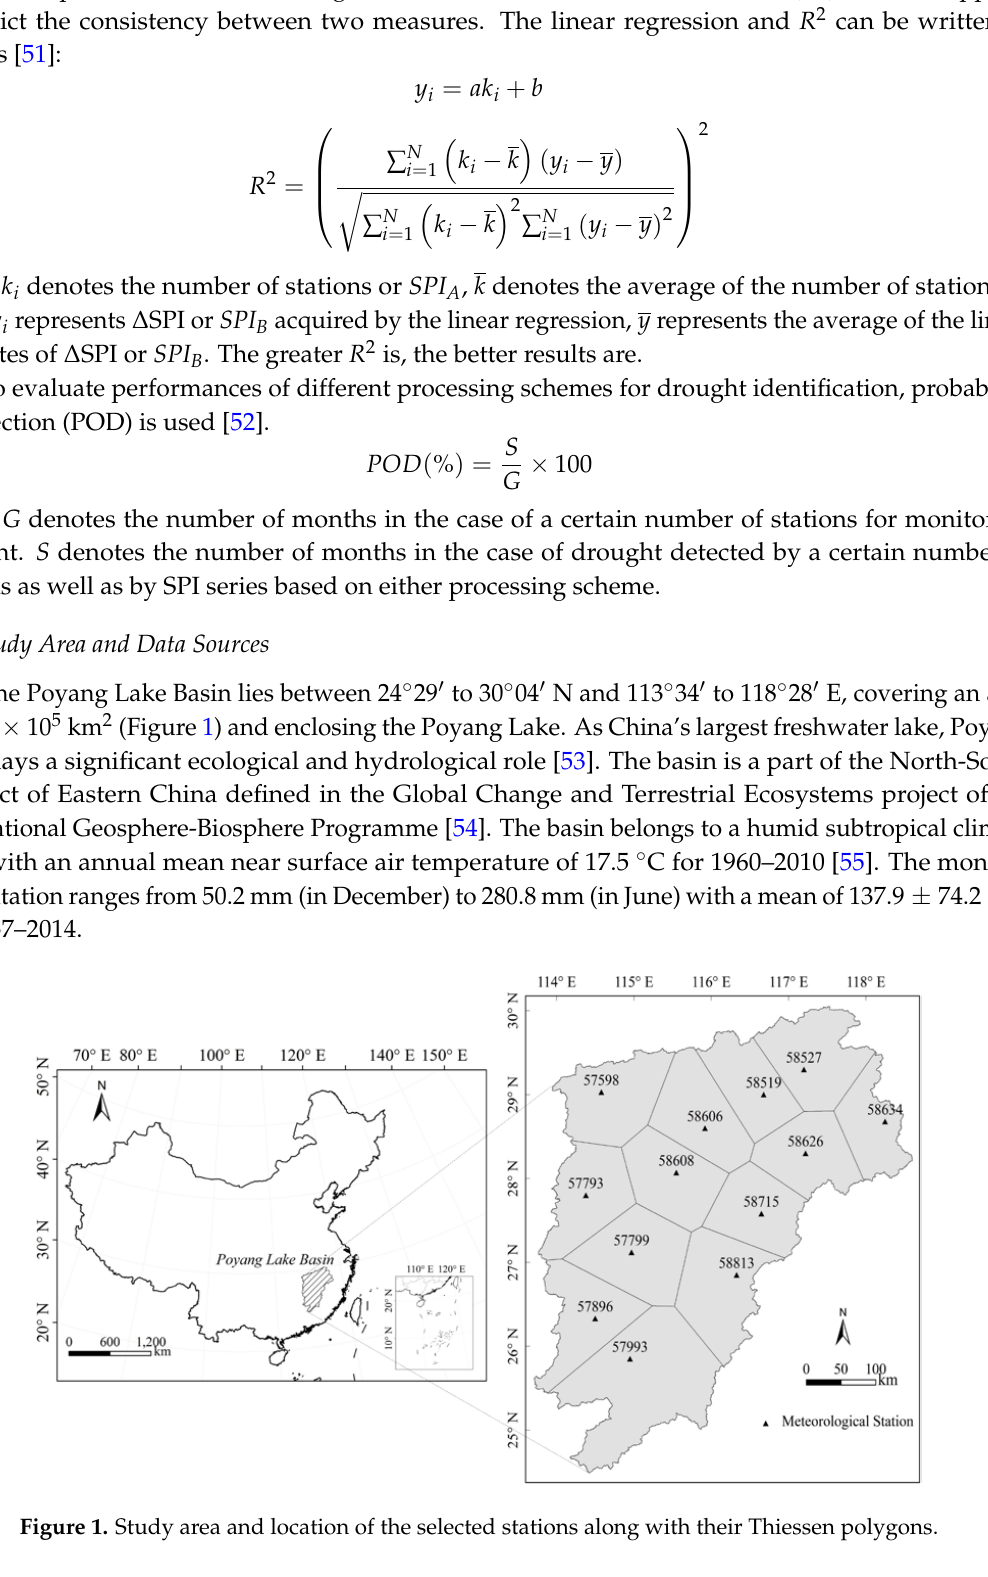
Table 2. Weighting values of selected meteorological stations.